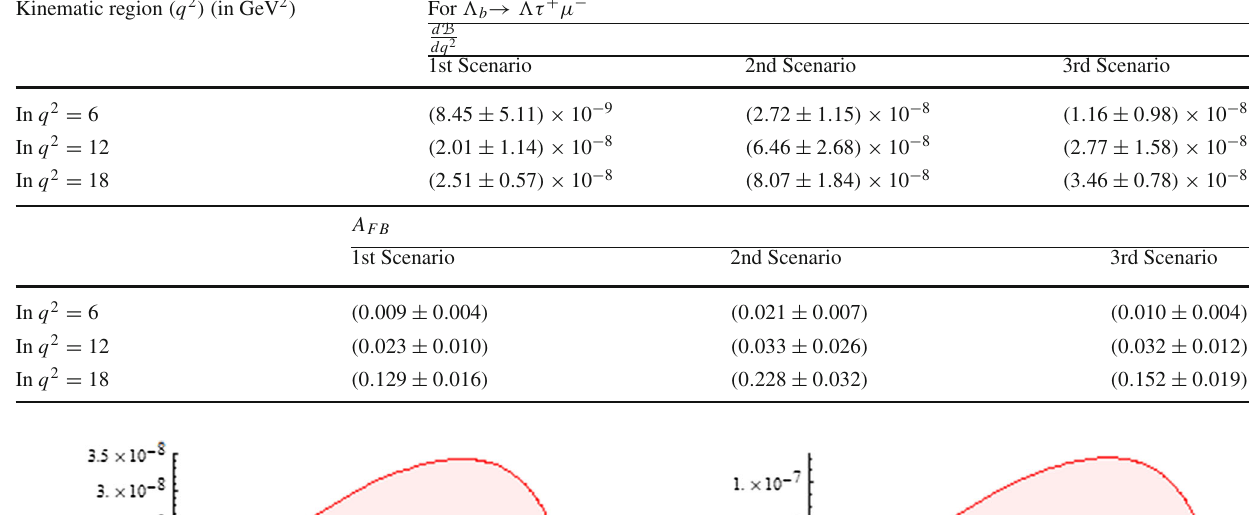
Table 3 Predicted values of differential branching ratios and forward backward asymmetries for (cid:2) b → (cid:2)τ + μ − decay in 1st, 2nd and 3rd scenarios Kinematic region ( q 2 ) (in GeV 2 )